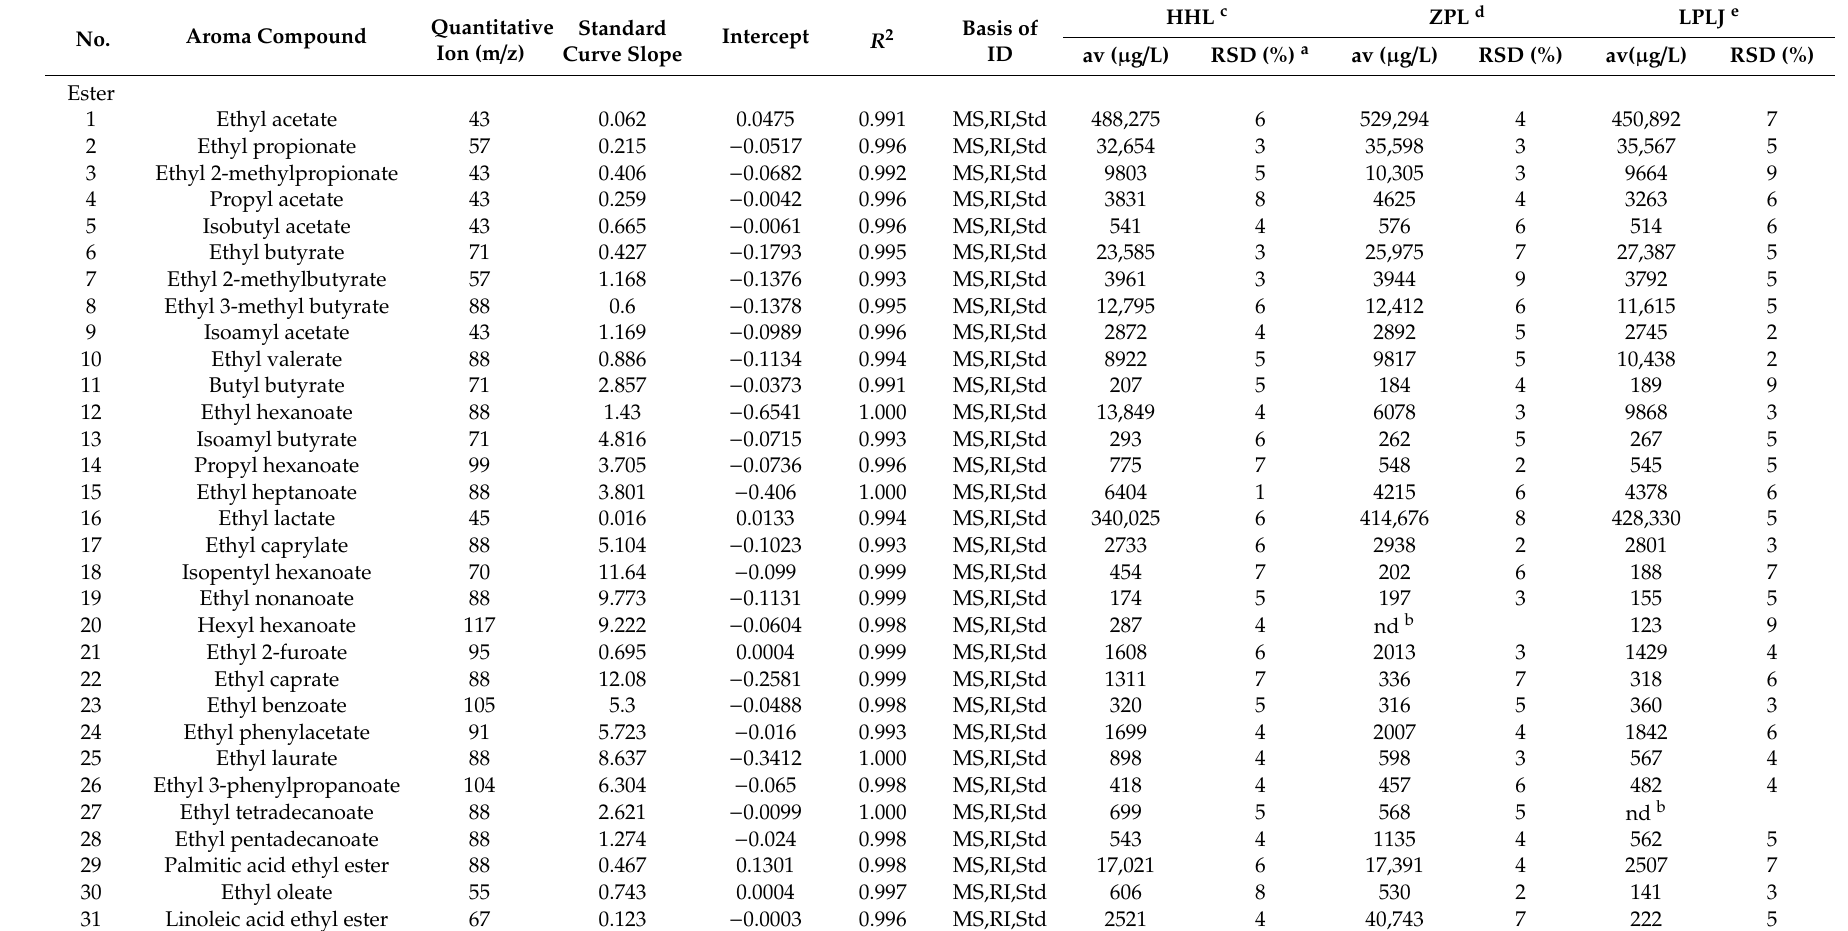
Table 2. Standard curves and concentrations of 31 odorants in three type Langjiu by